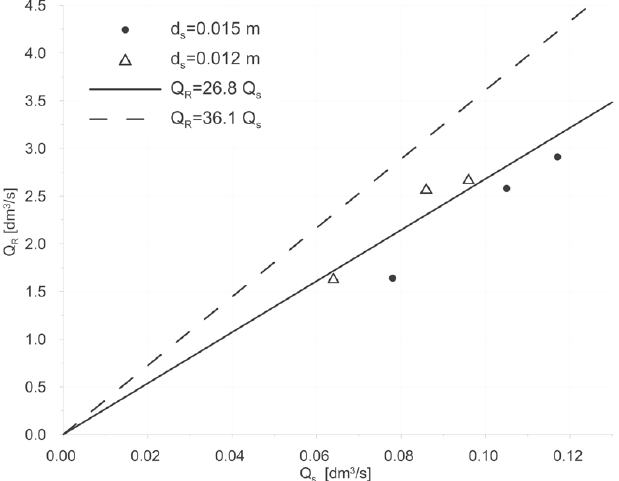
Figure 5. Sketch of the investigated circulating tank: plan view and axial cross-section.